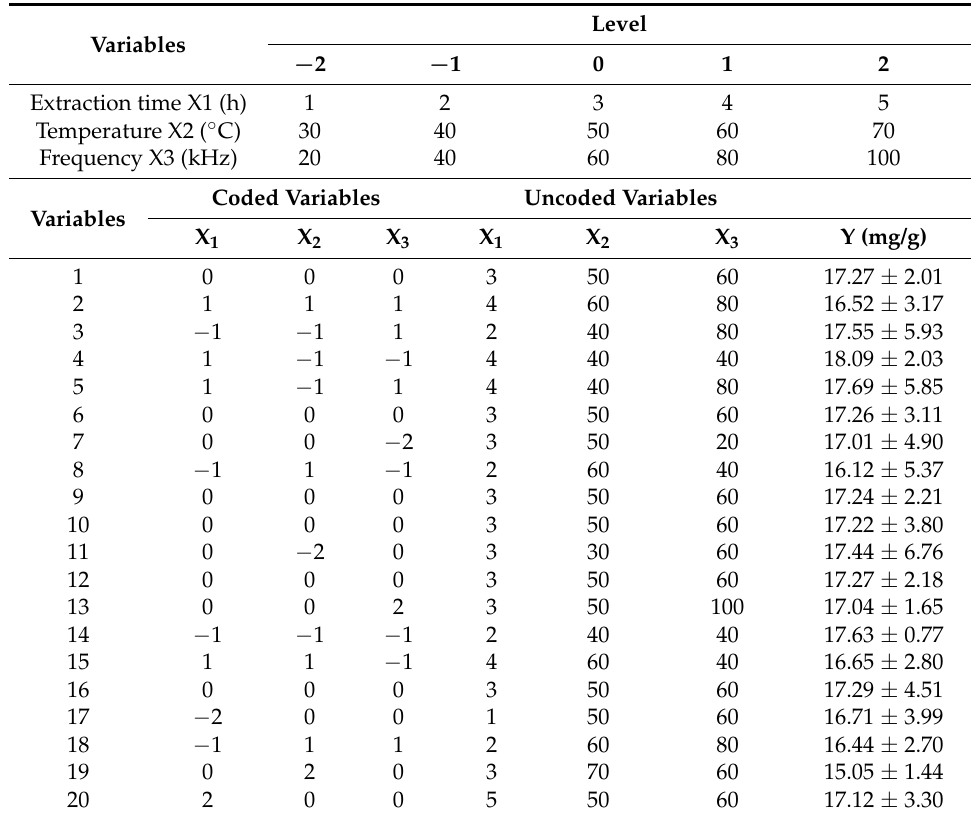
Table 1. Estimation of chlorophyll a contents in the extracts by the central composite experimental design for response surface